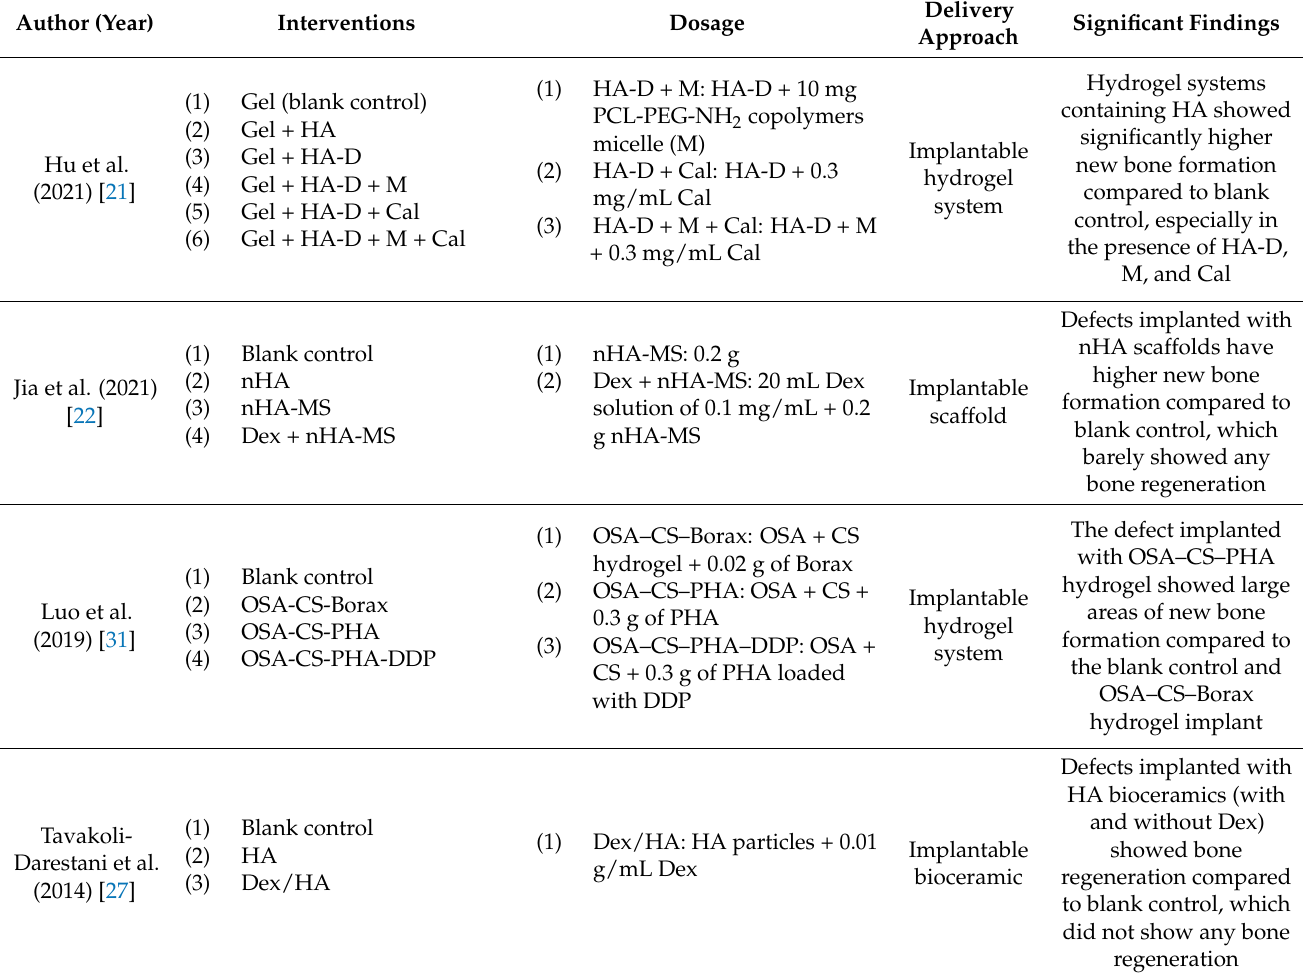
Table 5. Application of nHA for delivery of other drugs or bioactive